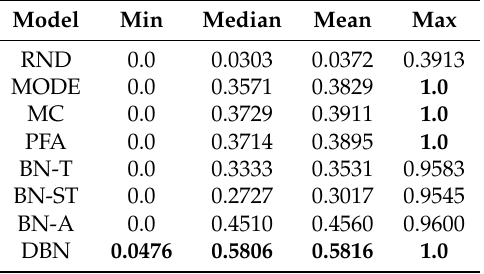
Table 1. Summary of model